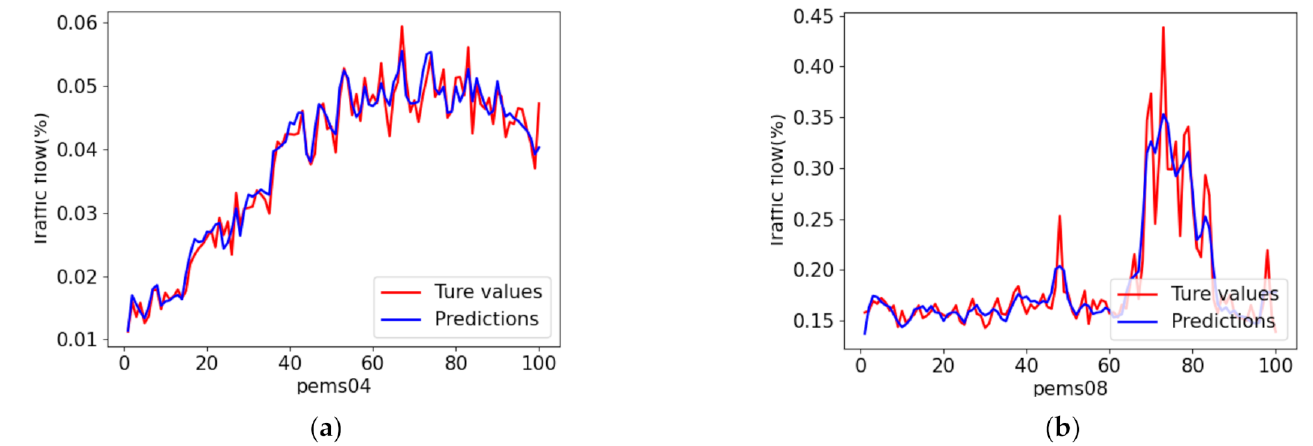
Figure 8. The visualization results for prediction. ( a ) Results on PEMS04 dataset. ( b ) Results on PEMS08